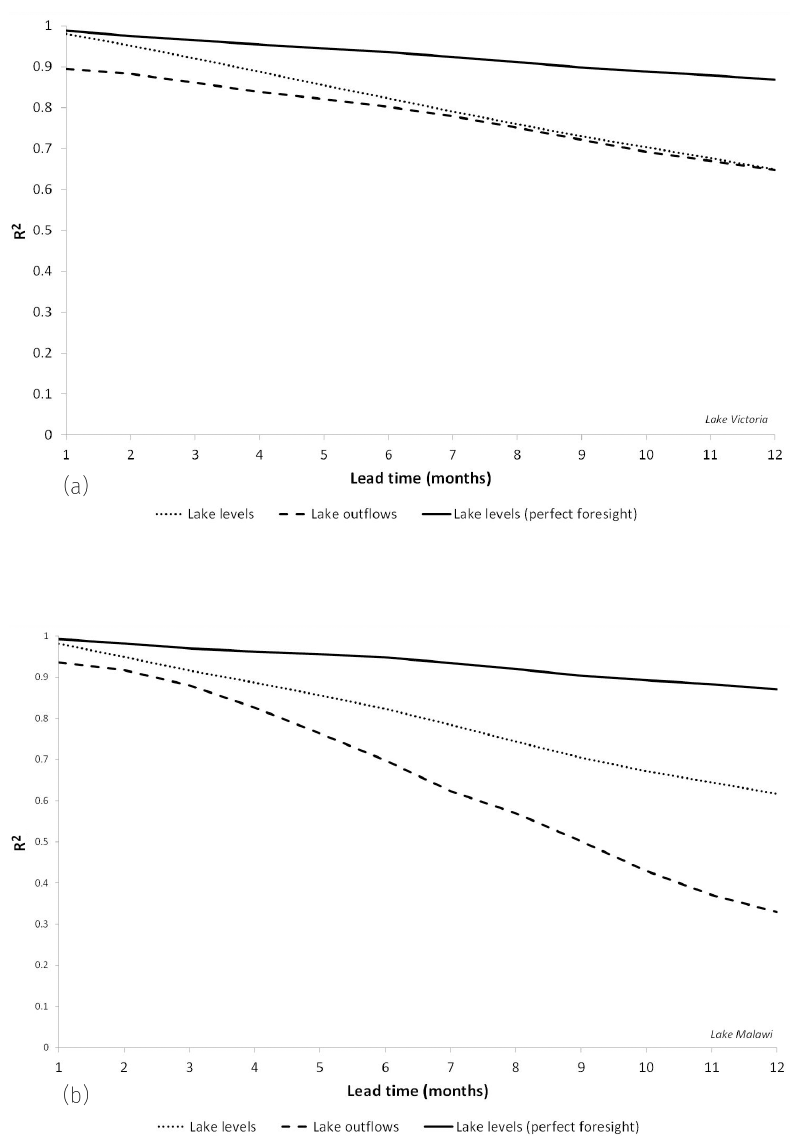
Figure 5. Variations in R 2 with lead time for levels and outflows for (a) Lake Victoria and (b) Lake Malawi using climatological rainfall inputs for the validation periods and – for levels – perfect foresight of